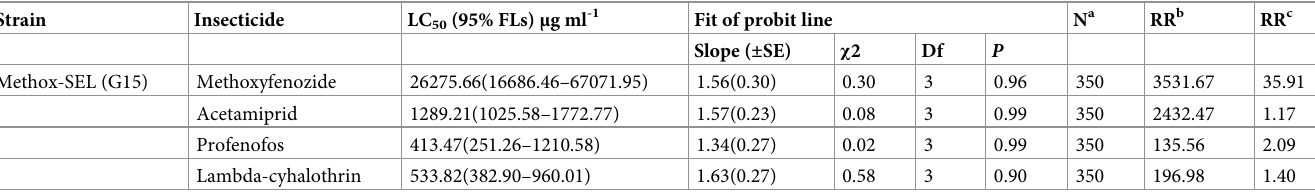
Table 1. Toxicity of various insecticides to Methox-SEL population of Chrysoperla carnea . Strain